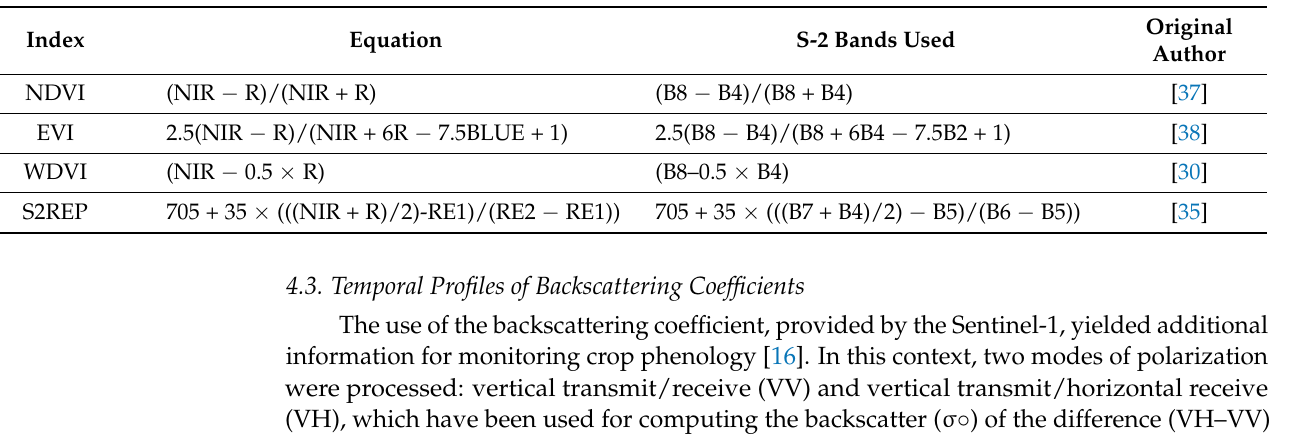
Table 4. Vegetation indices calculated from Sentinel-2 images. R = Red, RE = Red-Edge, NIR = Near- infrared, NDVI = Normalized Vegetation Index, EVI = Enhanced Vegetation Index, WDVI = Weighted Difference Vegetation Index, S2REP = S-2 Red-Edge Position